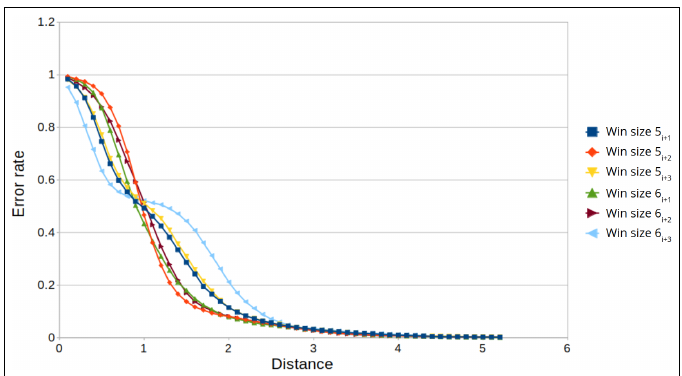
Figure 15. The FPR for a window size of 5 and 6 frames and an altitude of 100 m.